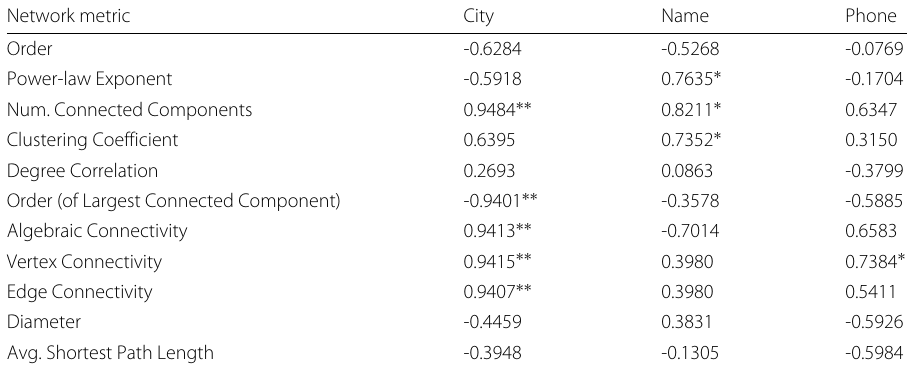
Table 8 Pearson correlation coefficients between F-Score and network metrics Network